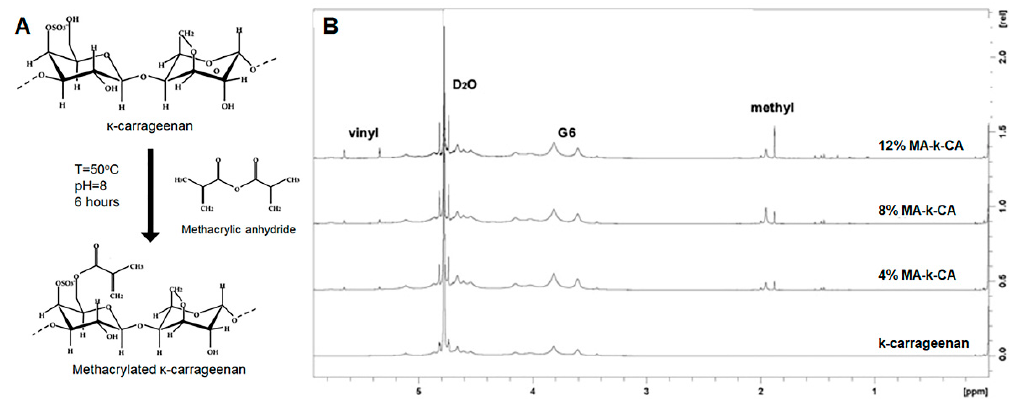
Figure 1. Schematic representation of the synthesis of MA- κ -CA and 1 H Nuclear Magnetic Resonance (NMR) spectra of κ -CA and MA- κ -CA (4, 8 and 12%). ( A ) Chemical modification of MA- κ -CA and ( B ) 1 H NMR spectra of κ -CA and MA- κ -CA recorded in deuterium oxide (D 2 O). The vinyl group peak was located at chemical shift ( δ ) = 5.3–5.8 ppm and methyl group peak at δ = 1.8–2 ppm. The D 2 O peak was located at δ = 4.6–4.8 ppm and β -galactose subunit of κ -CA (G6) were found around δ = 3.5–3.9 ppm.